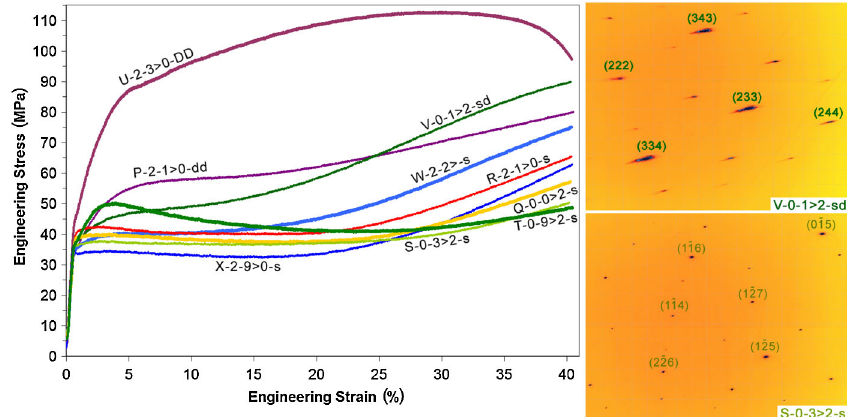
FIG. 6. (Color) Stress-strain curves for nine single crystals described in Table I oriented to investigate slip system interactions; some have a single slip direction (S) for much of the deformation (curves that are more nearly flat). Five specimens show softening, and three others have multiple slip directions activated (SD, DD) that cause stress increases (work hardening) from dislocation intersections, entanglements, and lattice rotations made evident by streaked diffraction patterns. The diffraction patterns from white synchrotron radiation represent orientations from a (cid:2) 1 (cid:4) m diameter column of atoms about 100 (cid:4) m deep.